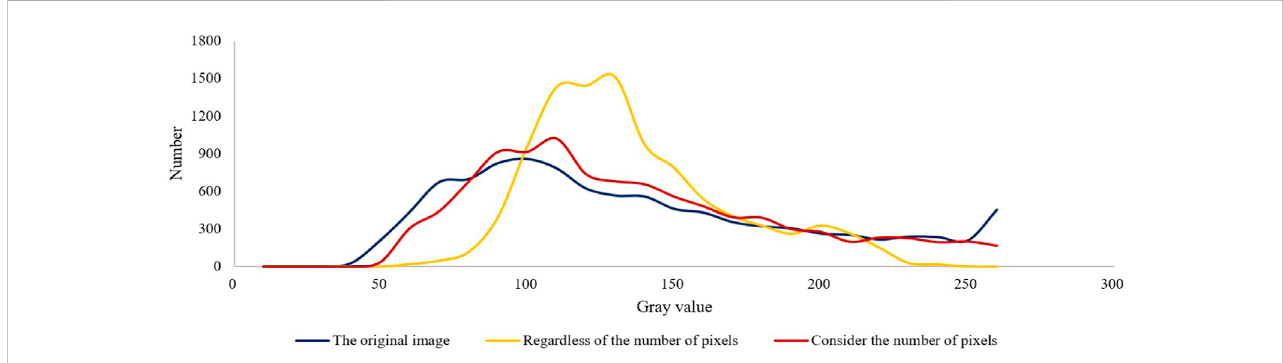
FIGURE 1 The number of gray values of different images.